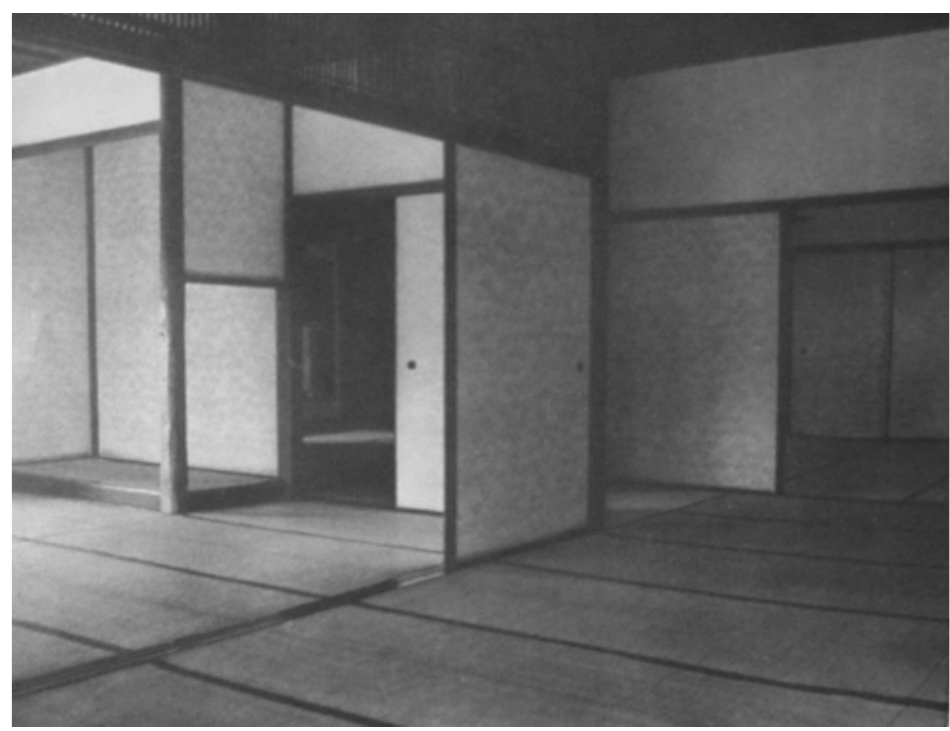
Figure 13 House Interior. The Japanese House and Garden, 1955. Tetsuro